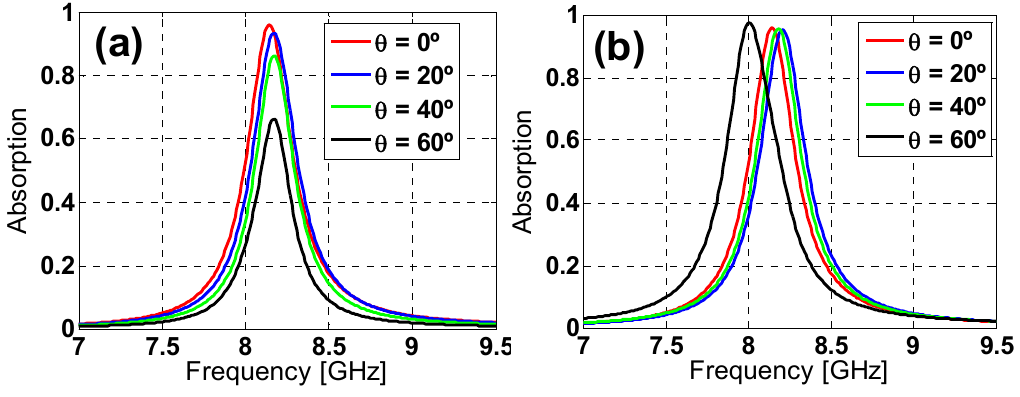
Figure 5. Hexagon design absorption simulation results under different incident angles ( θ ) for both ( a ) TE and ( b ) TM